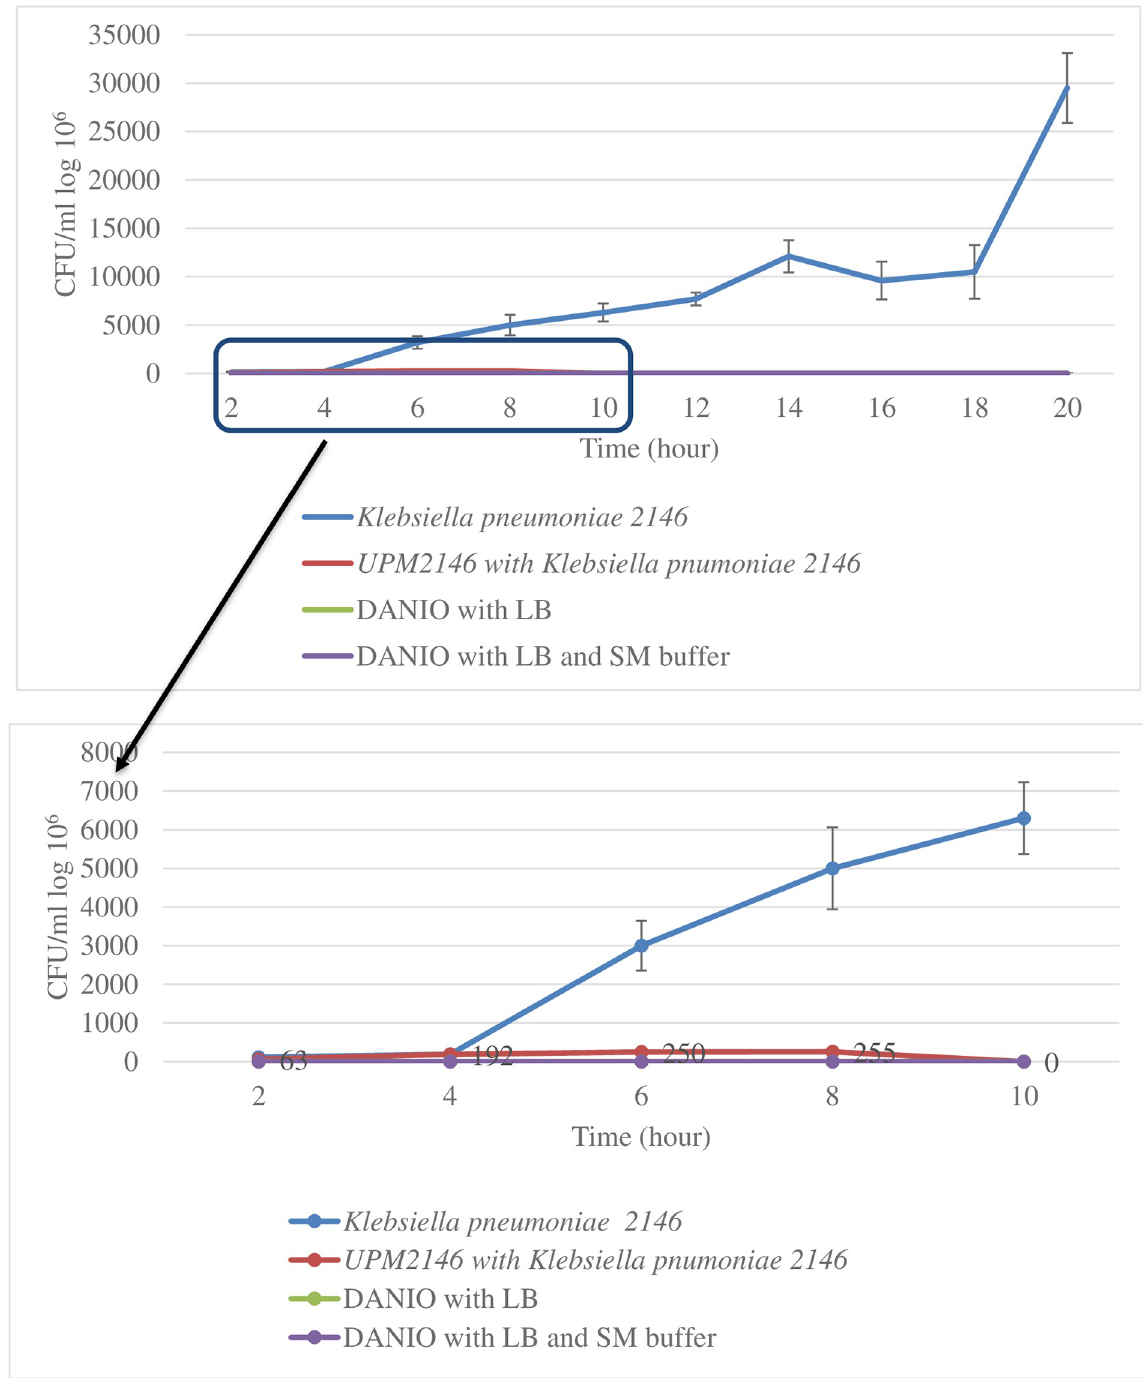
Fig 10. CFU count in zebrafish larvae. The phage UPM2146 managed to completely lyse K . pneumoniae 2146 at 10 h and remains zero until 20 h while the zebrafish larvae infected with bacteria ( K . pneumoniae 2146) continue to increase till reaching 25.3 x 10 6 CFU/ml. The experiment was done in